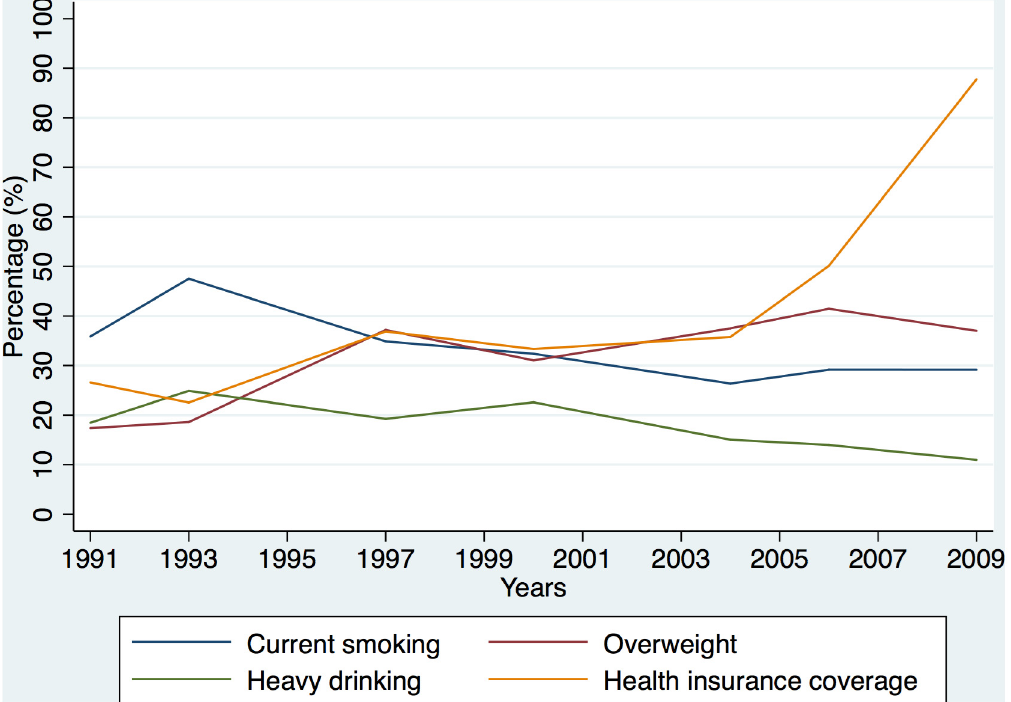
Fig 1. Trends in smoking, heavy drinking, obesity (including overweight and obesity) and health insurance coverage.